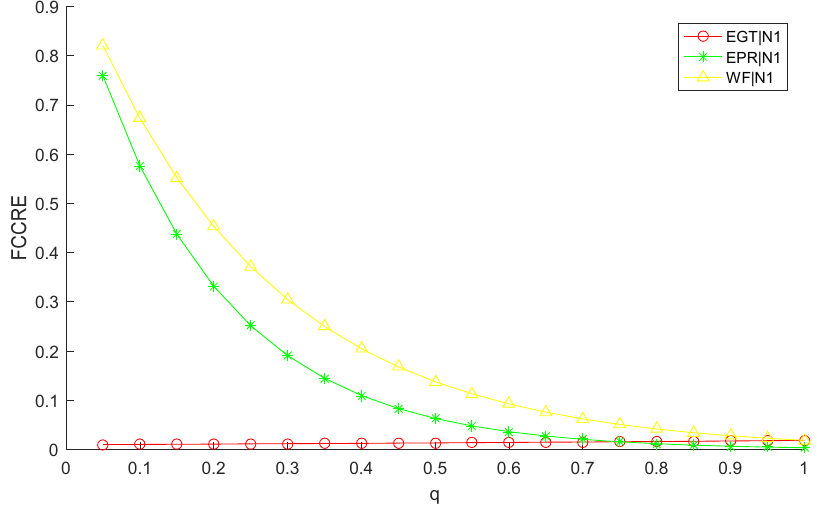
Figure 11. The fractional cumulative residual entropy of N1, EGT, EPR, and WF time series.